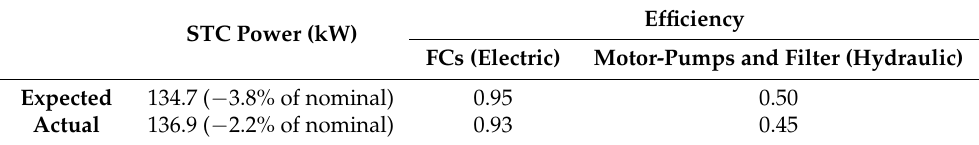
Table 5. Expected and actual STC power of the PV generator and FCs and motor-pumps